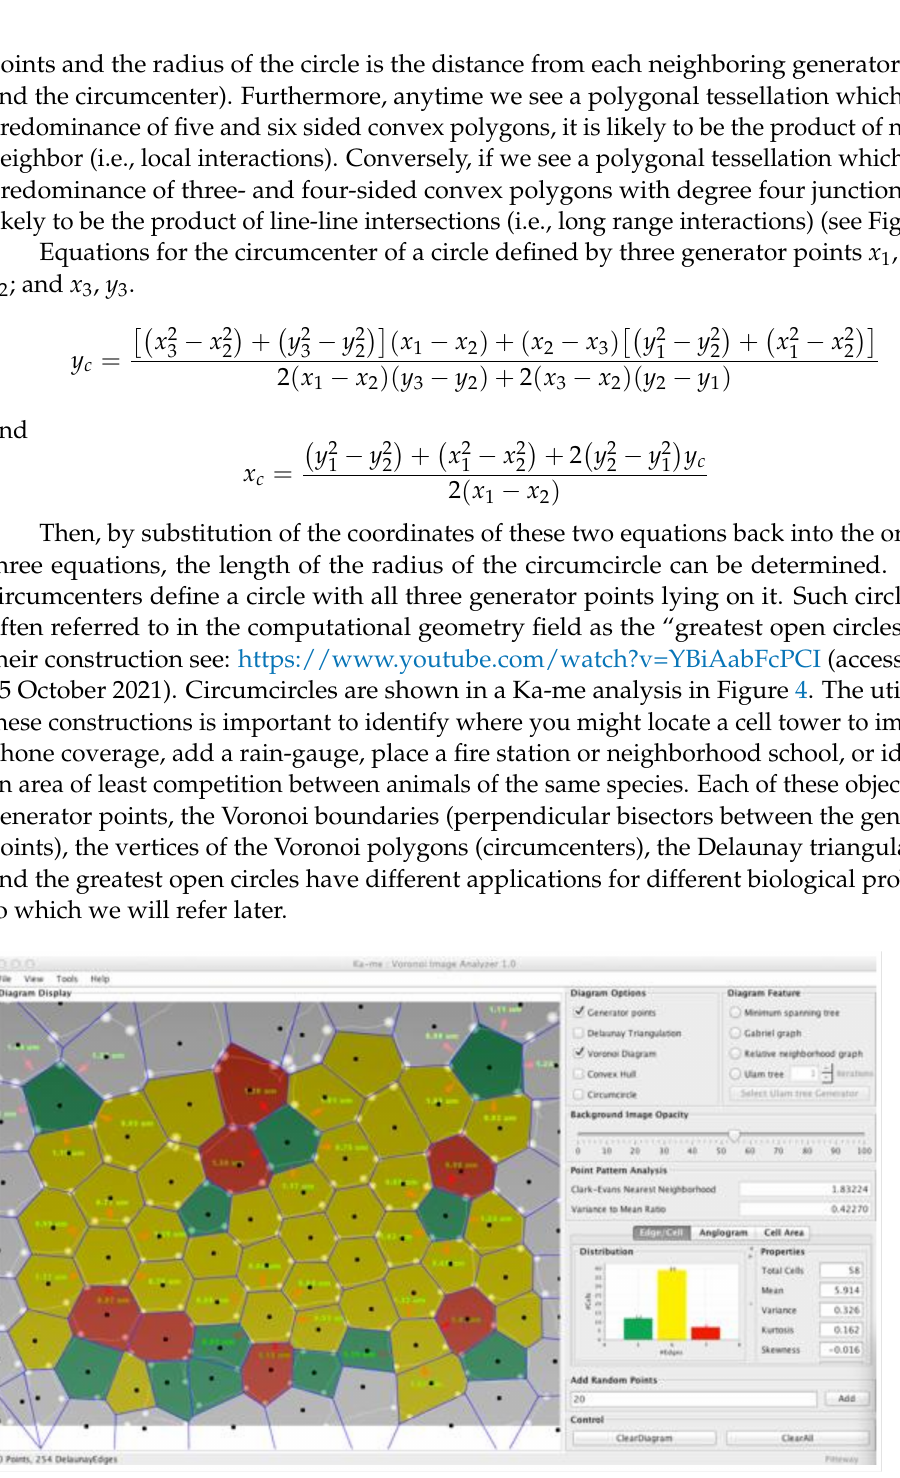
Figure 2. A screenshot of a Voronoi diagram tessellation generated by the software Ka-me which is superimposed on a medial axial transformation of the 3D nanotomography image of a test of a radiolarian generated with the software Amira. The blue lines are the edges of the Voronoi cells, and the light-yellow lines are the edges of Radiolarian test. The forty Voronoi cells lie within the convex hull as the edges of the polygons external to the convex hull extend beyond the rectangle containing the image. Only 5-, 6-, and 7-sided convex polygons are observed and notice that all junctions are Y-shaped (i.e., trigonal, vertices with degree = 3) which is illustrative of patterns generated by local, nearest neighbor interactions versus X-junctions produced by global intersecting lines (Figure